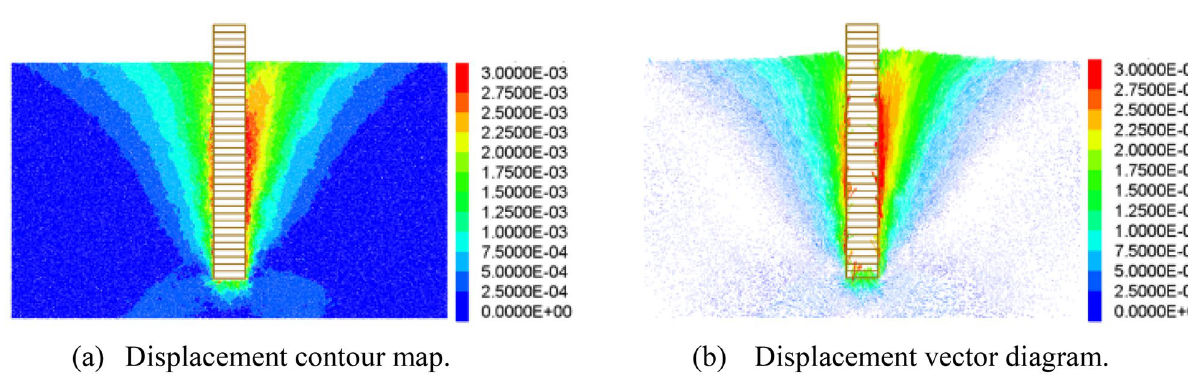
Figure 13. Soil displacement results of DEM